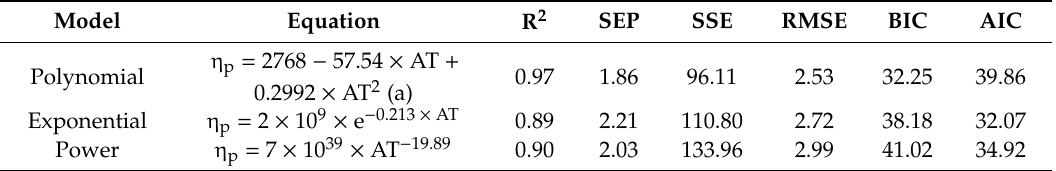
Figure 4. Apparent viscosity (mPa·s) of MPC85 of 4–21% TS measured using the reference method (rotational rheometer) versus AT (%) measured using an inline acoustic flowmeter. η p , viscosity of MPC85 predicted by prediction Equation (a); AT, acoustic transmission measured using an inline acoustic flowmeter; R 2 , coefficient of determination; SEP, standard error of prediction. Table 1. Parameters and regression co-efficient of the different models applied to predict apparent viscosity using acoustic transmission (AT). R 2 , coefficient of determination; SEP, standard error of prediction; SSE, error sum of squares; RMSE, root mean square error; BIC, Bayesian information criterion; AIC, Akaike information criterion.